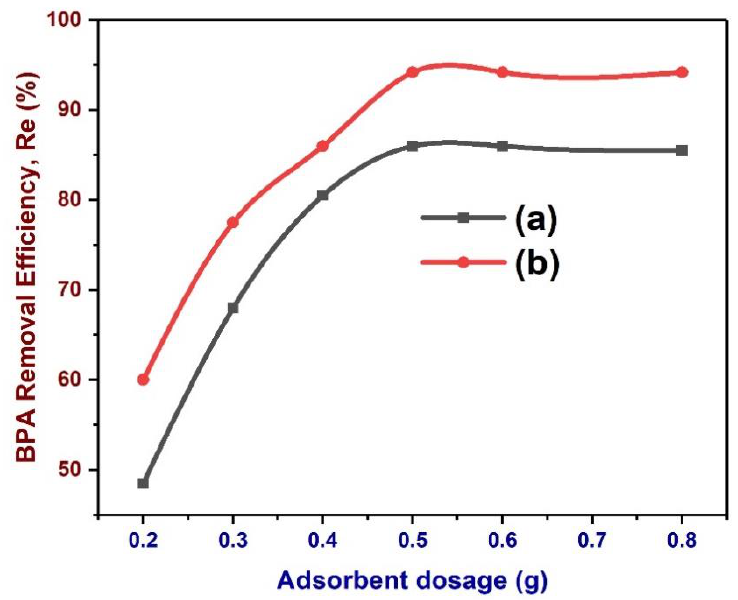
Figure 9. Effects of BC (a: NBC, B: MBC) dose on the removal of BPA. BPA removal efficiency by BC under varying doses: 0.2 – 0.8 g; BPA concentration: 20 ppm; temperature: 293.15 K; pH: 6.0; and BC under varying doses: 0.2–0.8 g; BPA concentration: 20 ppm; temperature: 293.15 K; pH: 6.0; and contact time: 60 min. contact time: 60